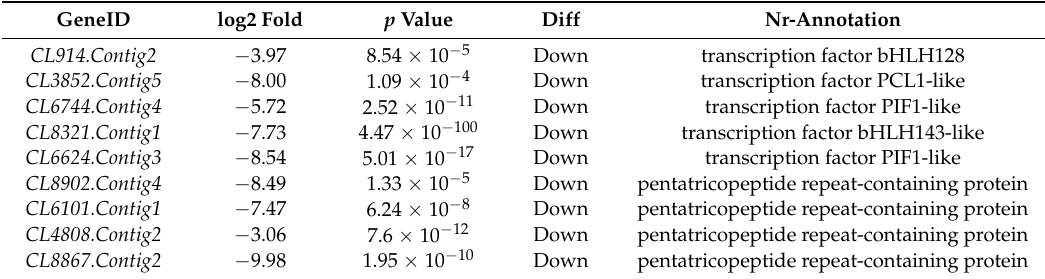
Table 4. Genes related to transcription factors and pentatricopeptide repeat-containing protein.